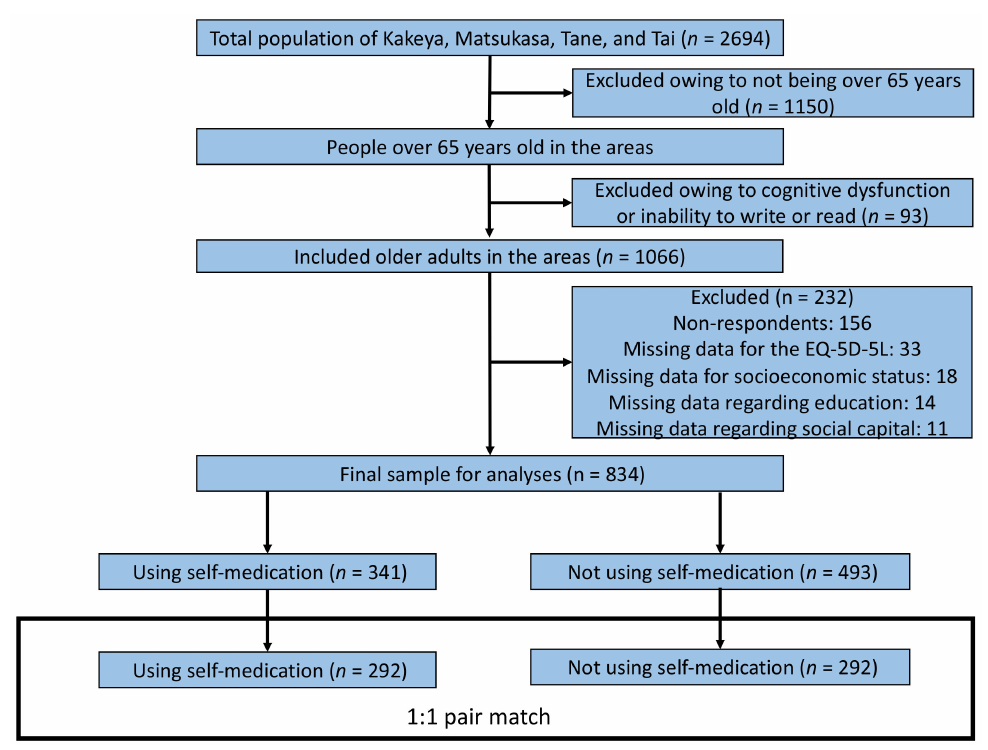
Figure 1. Participant selection